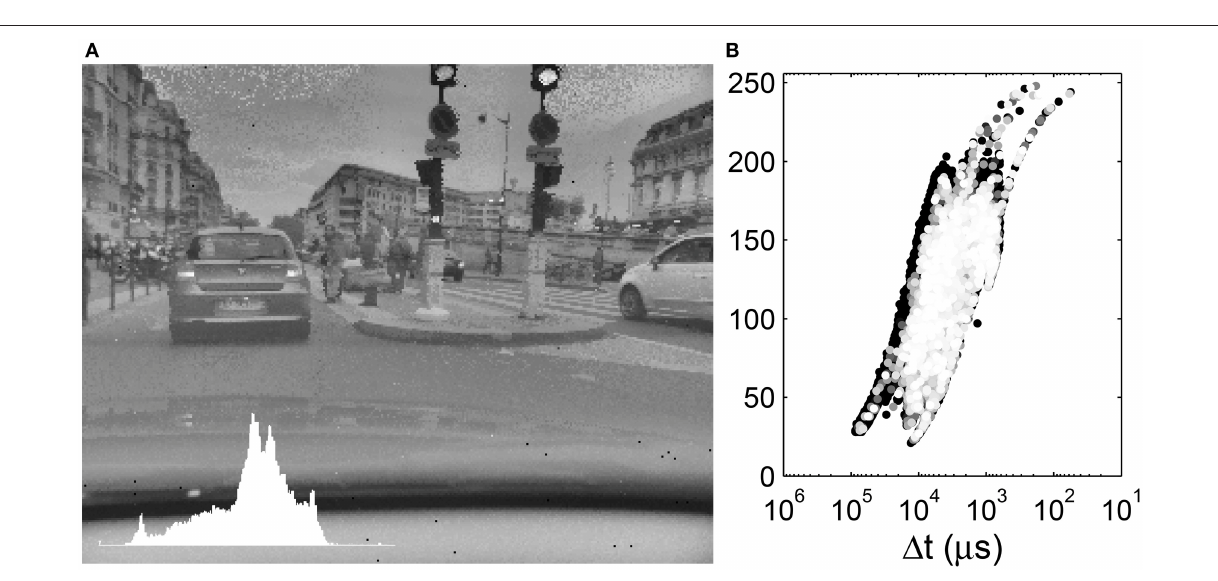
acquisitions taken from a car: “city” and “tunnel.” The evolution of the dynamic range of these outdoor scenes is illustrated in Figure 8 . This figure shows the evolution of minimum, median and maximum luminance of the videos over time. The dynamic range is represented by the area between the top and bottom curves. It is calculated after each incoming event using: max T . DNR( t ) = 20 log 10 min T